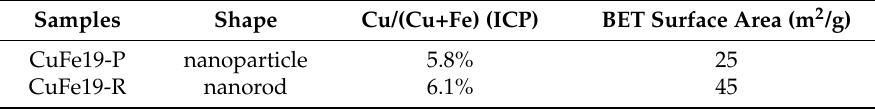
Figure 2. ( a ) XRD patterns and ( b ) N 2 adsorption-desorption isotherms of CuFe19-P and CuFe19-R, where the inset of ( b ) is pore size distribution. Table 1. Physical properties of CuFe19 ‐ P and CuFe19 ‐ R.